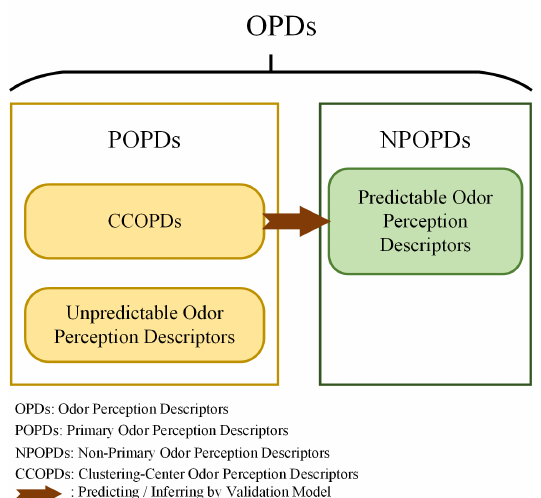
Figure 2. The classification of odor perception descriptors (OPDs). All OPDs fall into two categories: POPDs and NPOPDs, and the POPDs include CCOPDs and unpredictable odor descriptors. The perceptual ratings of NPOPDs could be inferred from the CCOPDs